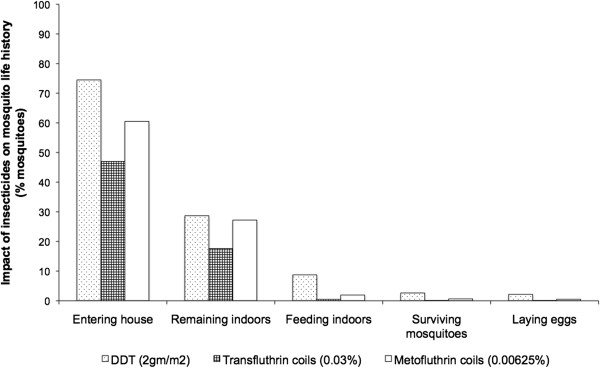
Impact of insecticides on mosquito behaviour around and insides houses. The graph illustrates the effect of DDT, Transfluthrin and Metofluthrin coils on the house entry and behaviour of 100 female An. arabiensis and An. gambiae s.s. mosquitoes are approaching the house. Assumptions made included the fact that deterrence was the first mode of action followed by irritancy, feeding inhibition, toxicity and fecundity. The data used was derived from field experiments for deterrence and semi-field system experiments for irritancy, feeding inhibition, toxicity and fecundity.